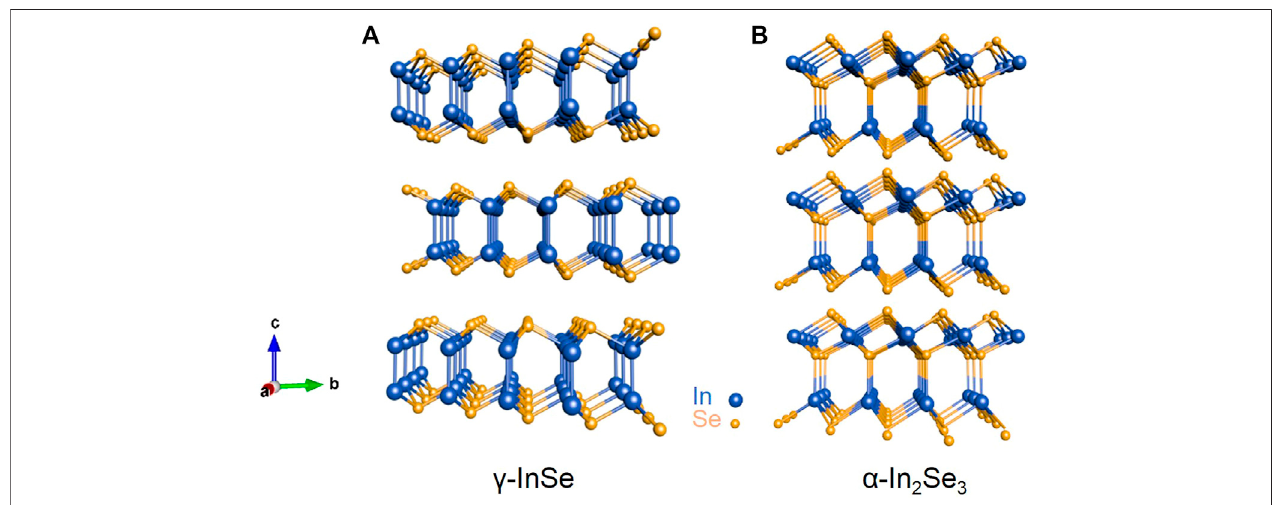
FIGURE 1 | Schematic rhombohedral crystal structure of γ -InSe consisting of quadruple Se-In-In-Se layers (A) and α -In 2 Se 3 composed of Se-In-Se-In-Se quintuple layers (B) in 3D form.